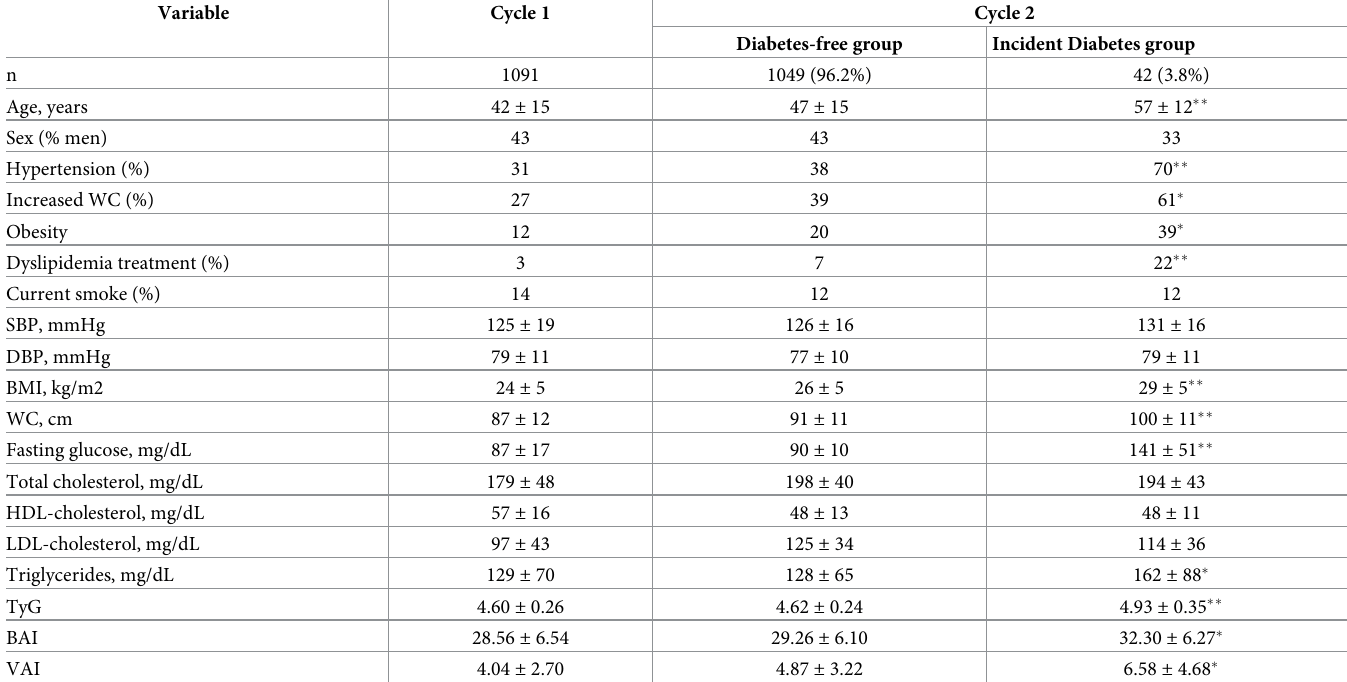
Table 1. Clinical characteristics at baseline (Cycle 1) and 5-year follow-up (Cycle 2) in the normoglycemic sample of the Baependi Heart Study.